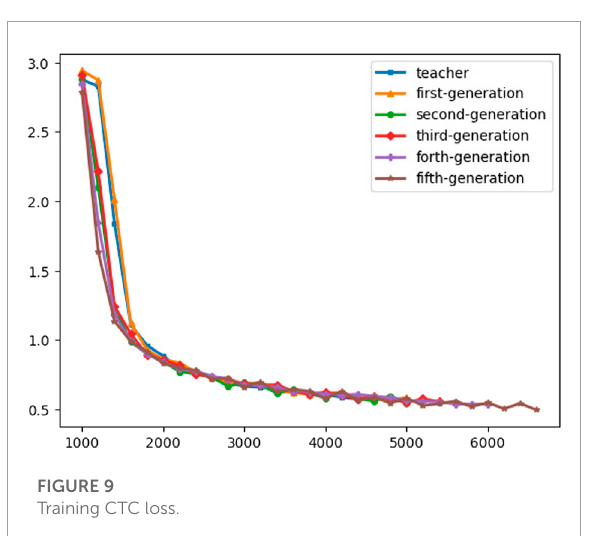
FIGURE 9 Training CTC loss.